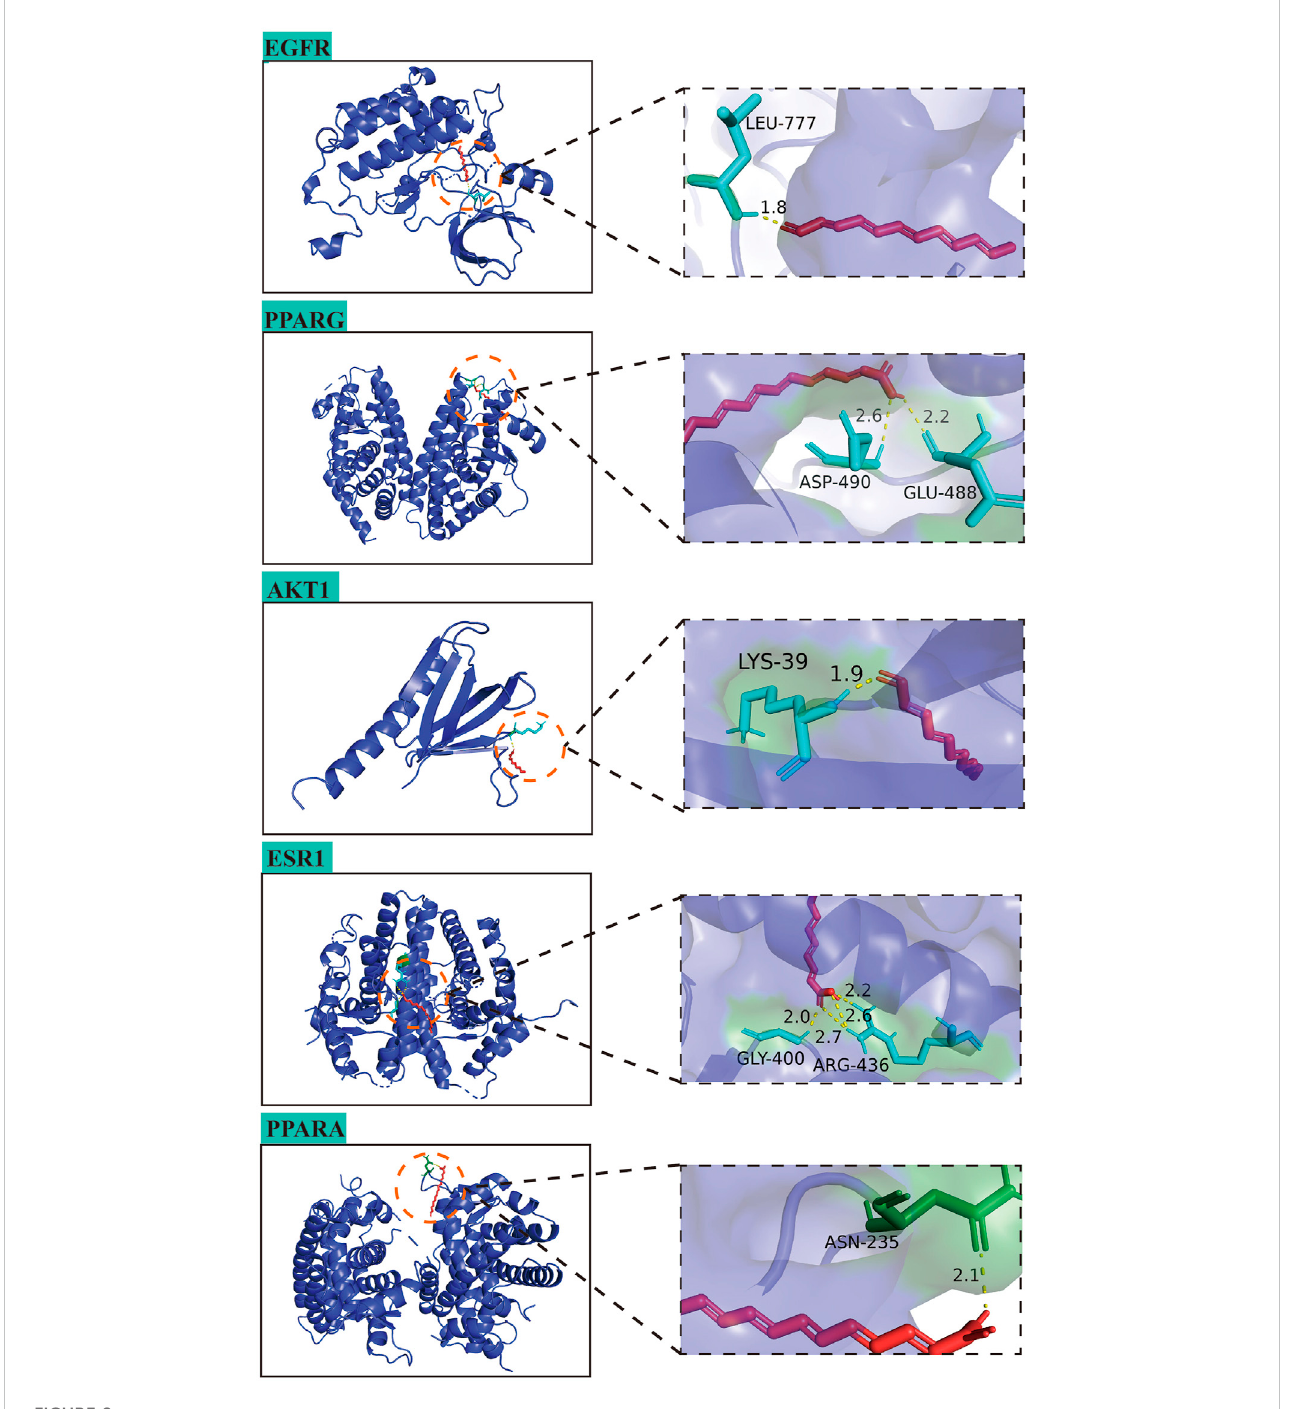
FIGURE 8 Molecular docking diagrams of AD-MFS and top fi ve hub